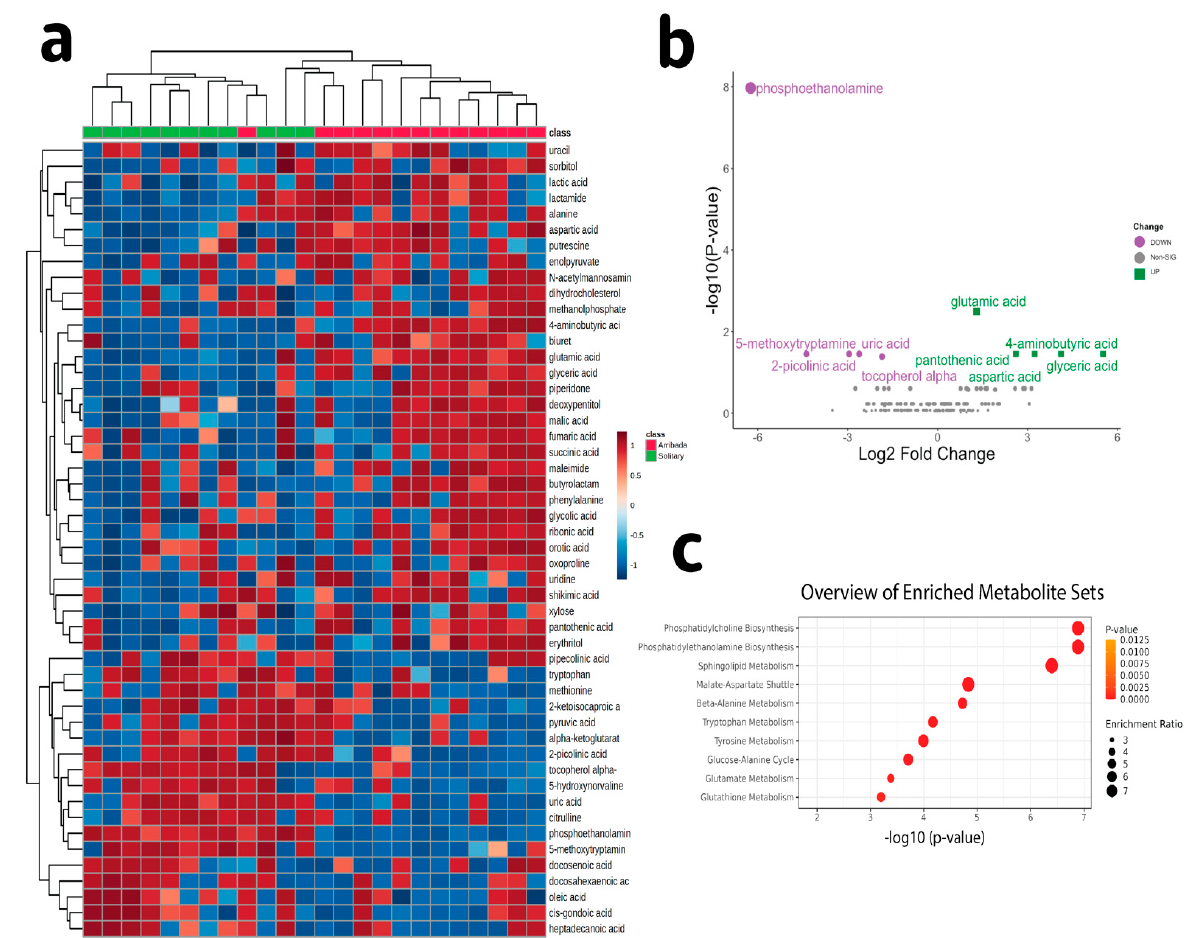
Figure 3. Metabolite profiling. ( a ) Heat map showing the 50 most abundant metabolites in olive ridley plasma, ( b ) Volcano plot showing differentially expressed metabolites in arribada compared to solitary nesters (5% FDR), and ( c ) Enrichment pathways showing significantly enriched pathways in arribada compared to solitary